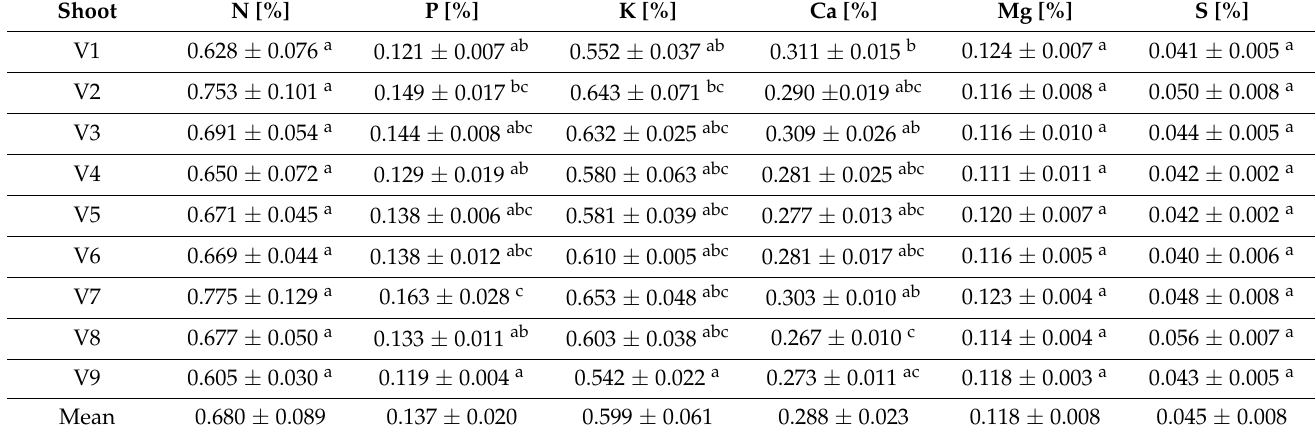
Table 5. Percentage of macroelements in the stems from each substrate density variant after growing the seedlings ( ± SD). The letters a, b and c indicate significant differences between the means.